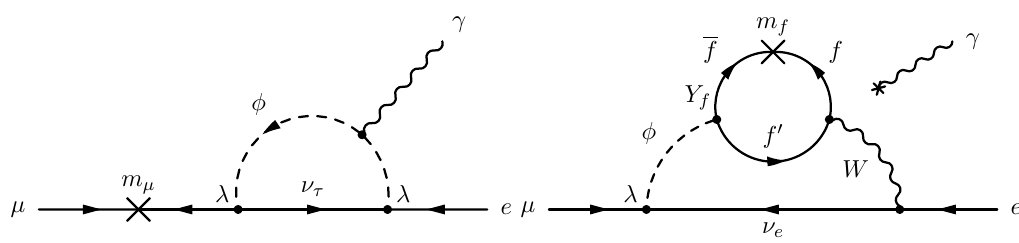
Figure 2 . Leading one- and two-loop contributions to (cid:22) ! e(cid:13) . In the two-loop (cid:12)gure the external photon can be connected to any charged line in the loops, and f refers to either up-type quarks, down-type quarks, or